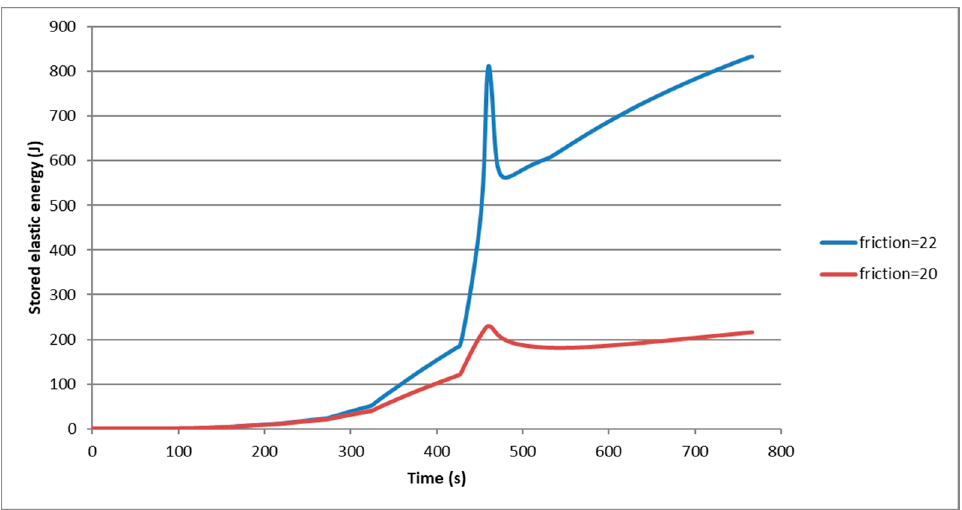
Figure 10. Elastic energy stored in the fault during the injection test.